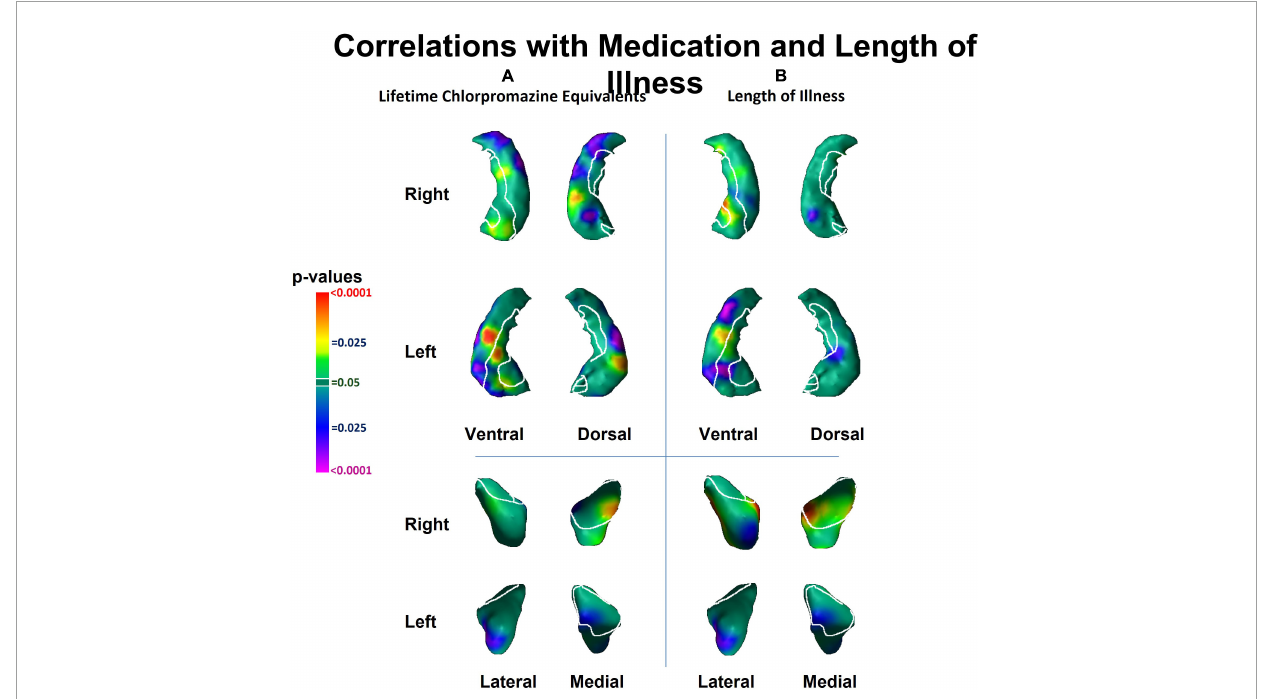
FIGURE3 Associations of lifetime chlorpromazine equivalents and of length of illness with surface morphology of the hippocampus and amygdala. Statistical maps for the association of panel (A) lifetime chlorpromazine equivalents and (B) length of illness with surface morphological measures (Euclidian distances) of the hippocampus and amygdala. The effects of medication and lifetime illness on surface measures overlapped with the regions of the hippocampus and the amygdala where we detected diagnosis effects ( Figure 1